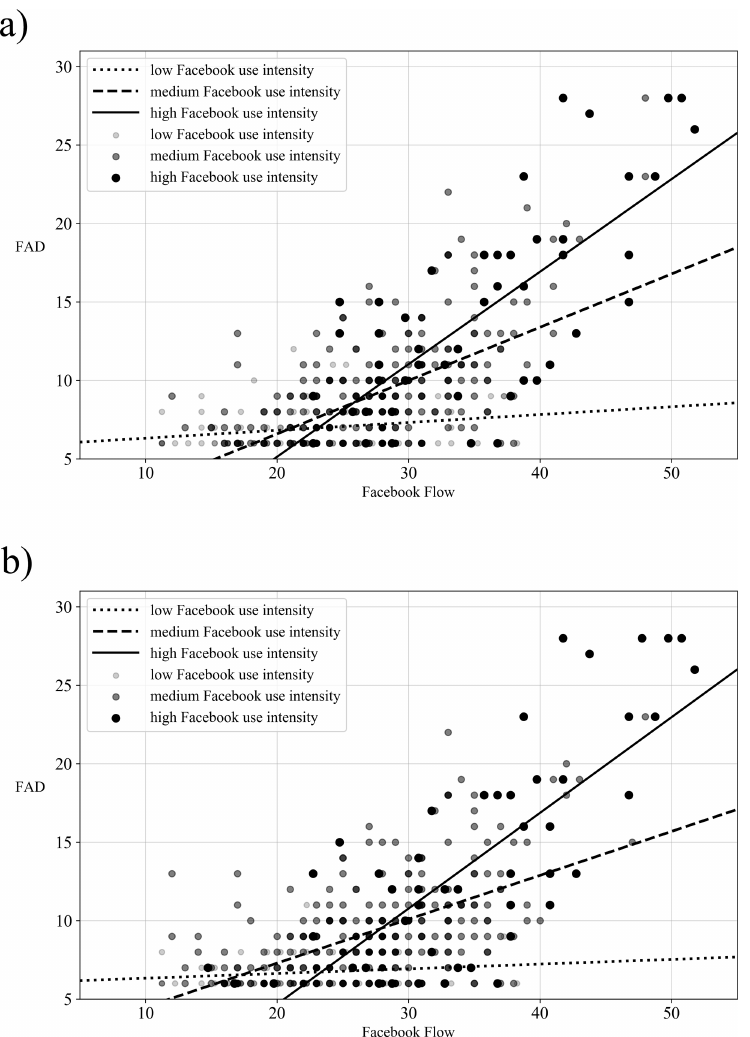
Fig 2. a. Moderating effect of Facebook use intensity (operationalized by Facebook Intensity Scale) on Facebook flow to FAD; b. Moderating effect of Facebook use intensity (operationalized by composite index including duration of Facebook membership, frequency of daily Facebook use, duration of daily Facebook use and Facebook Intensity Scale) on Facebook flow to FAD.